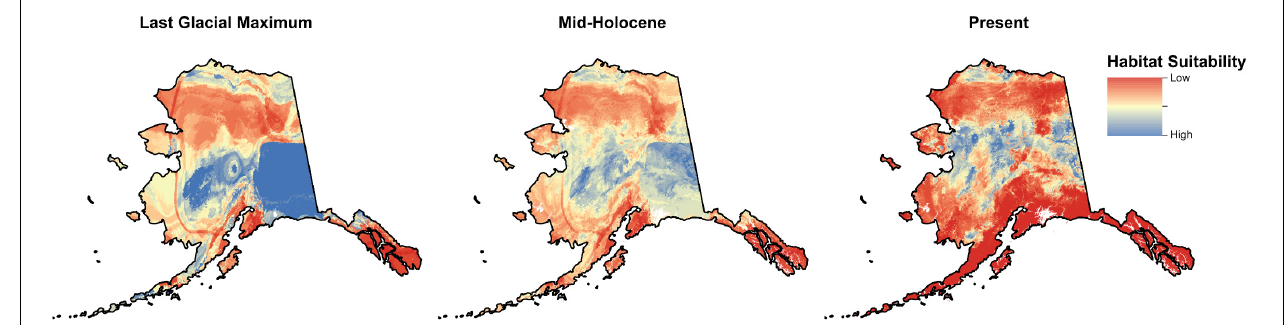
FIGURE 5 | MaxEnt environmental niche model (ENM) maps of Alaska, United States adapted to depict Eriophorum vaginatum habitat suitability during the Last Glacial Maximum (LGM), Mid-Holocene and present. Modeled LGM layers were derived from the Community Climate System Model (CCSM) (Braconnot et al., 2007). Current and LGM layer habitat suitability bin values were averaged to create the Mid-Holocene climate raster.